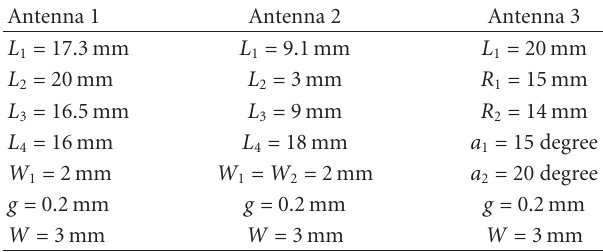
Table 1: Antenna